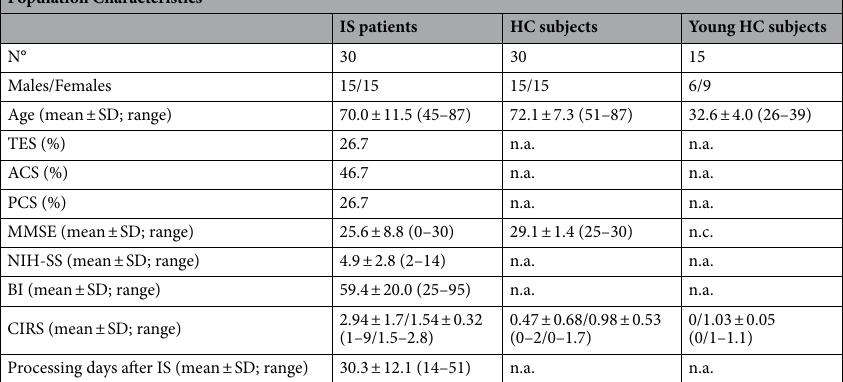
Table 1. Study population and clinical data. TES, Thrombo-Embolic Stroke; ACS, Anterior Circulation Stroke; PCS, Posterior Circulation Stroke; MMSE,, Mini-Mental State Examination; NIH-SS, National Institutes of Health Stroke Scales; BI, Bartel Index; n.c., not